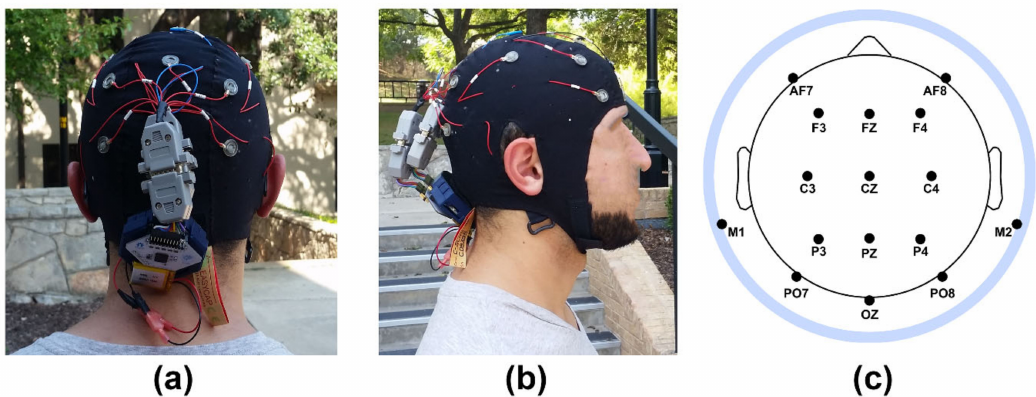
Figure 2. Mobile EEG recording setup: ( a ) Back view of EEG cap and recording amplifier. The amplifier was attached to the back of the cap via a Velcro patch and connected to cap leads via a custom-made connector; ( b ) Side view of EEG cap and recording amplifier. ( c ) Extended 10–20 scalp locations of EEG recording electrodes. Selected electrodes of interest (EOIs) for data analysis were sites FZ and OZ. Note that M1/M2 sites outside the radius of the head represent locations that are below the equatorial plane (FPZ-T7-T8-OZ plane) of the (assumed spherical) head model. Site LVEOG was located below the left eye approximately at the same latitude as sites M1 and